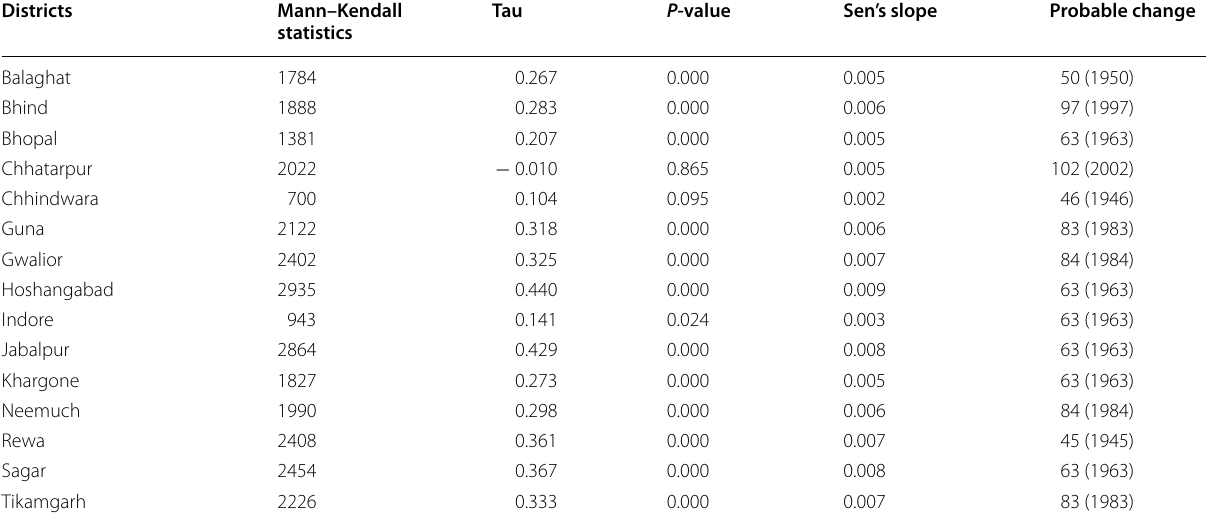
Table 3 The trend in annual maximum temperature of 115 years (1901–2016) in the 15 districts of Madhya Pradesh state of central India selected for study as per Mann–Kendall test and Sen’s estimator showing a significant increasing trend for maximum temperature for all the selected districts of Madhya Pradesh except Chhatarpur and Chhindwara districts which were found to be